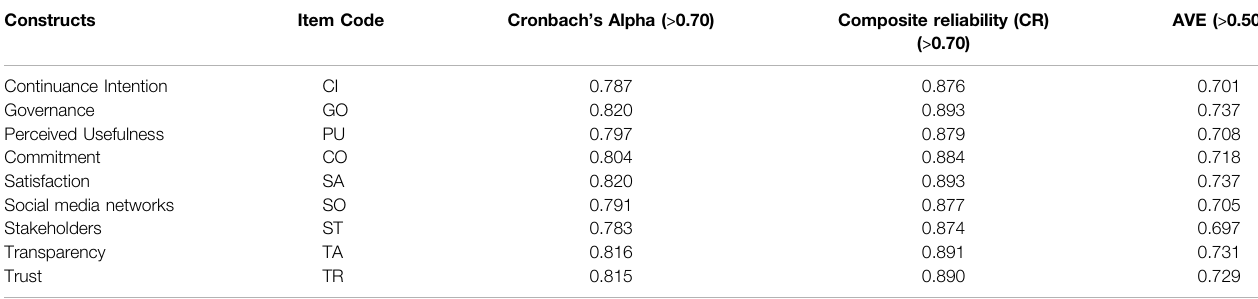
TABLE 2 | Construct reliability and validity. Constructs Item Code Cronbach ’ s Alpha ( >